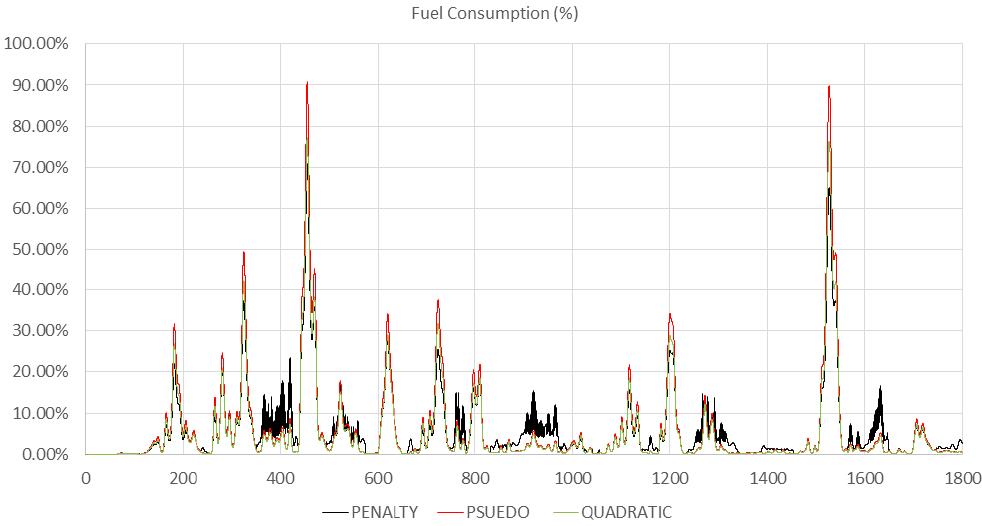
Figure 16. Fuel-Consumption Time Histories Compared to Maximum Capacity by Three Different Thrust-Allocation Algorithms.